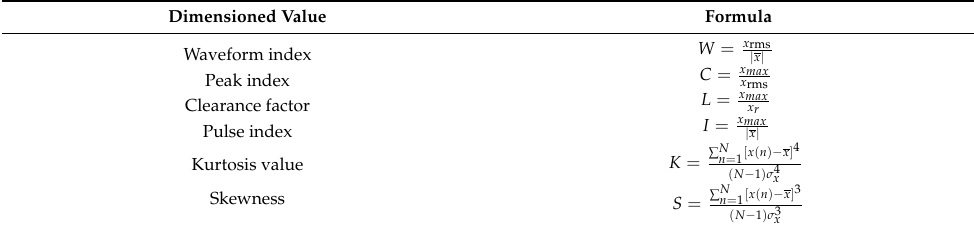
Table 2. Calculation formula of dimensionless indicators in time-domain signals.